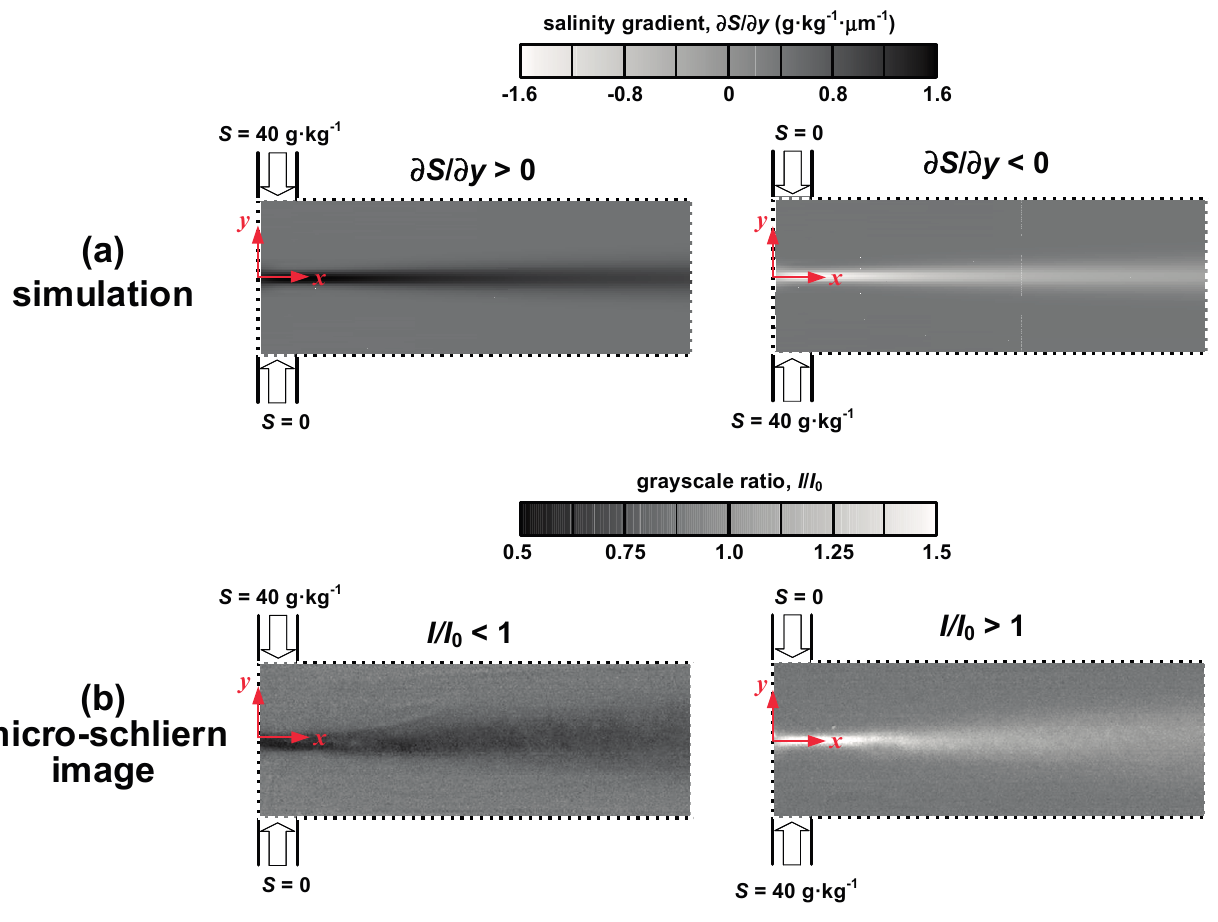
Figure 2. ( a ) Distributions of salinity gradient (numerical simulation); ( b ) Grayscale ratios (micro-schlieren images) in the T-microchannel, Re =